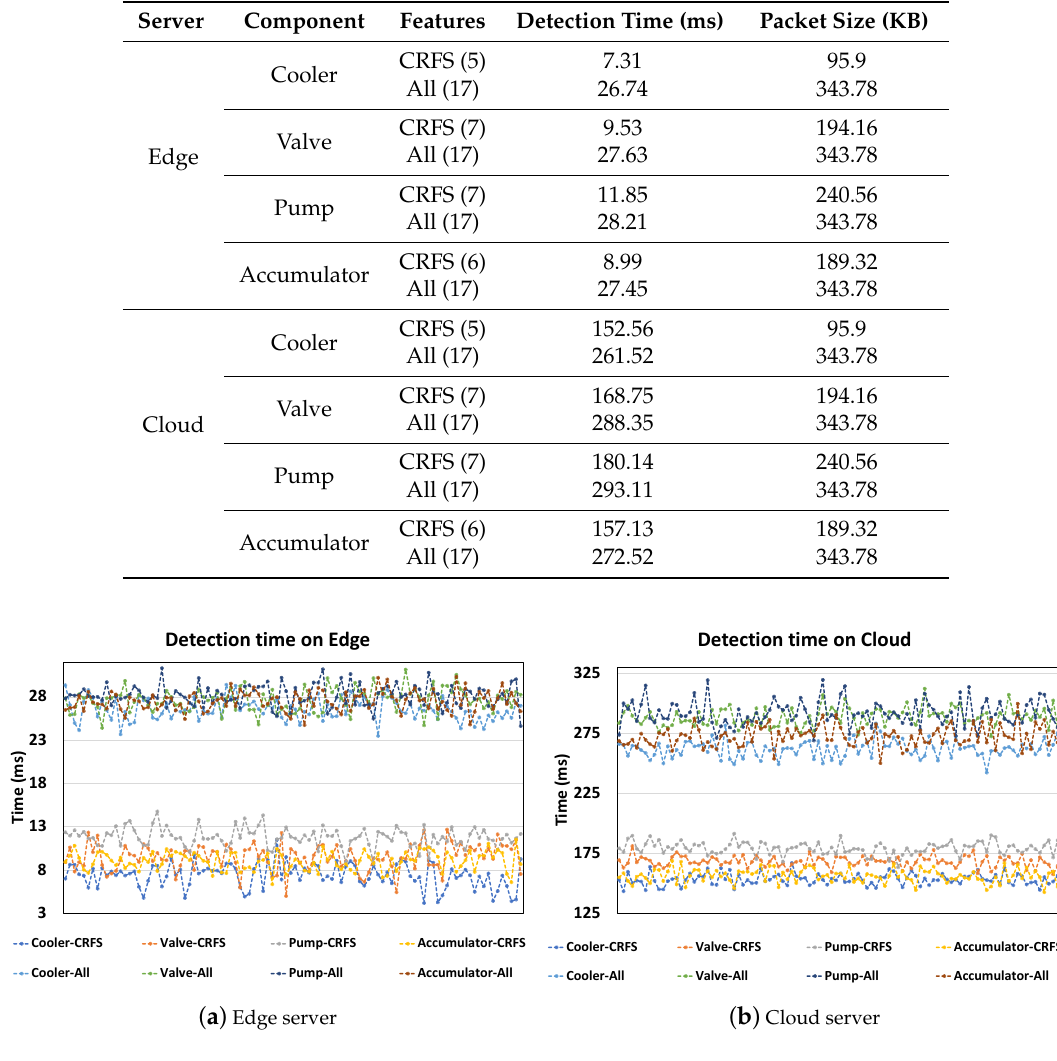
Figure 7. Detection times by the